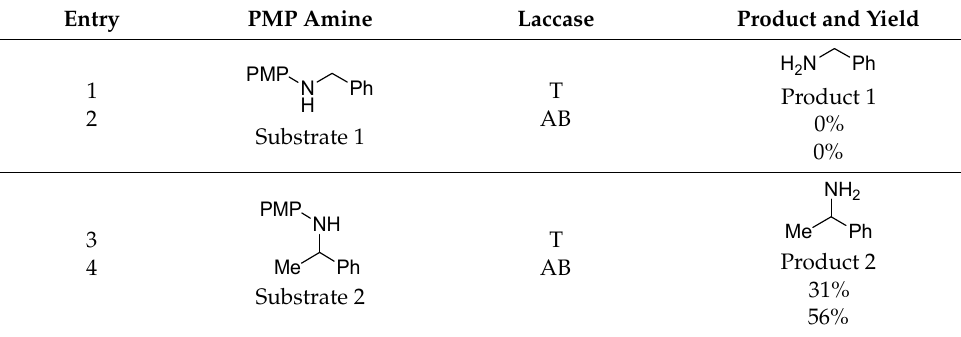
Table 2. Substrates catalyzed by Laccase for N-PMP removal.